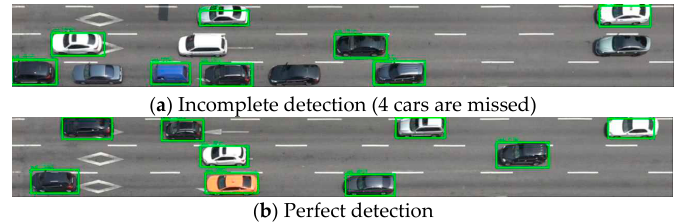
Figure 15. A success and a failure in YOLO detection.